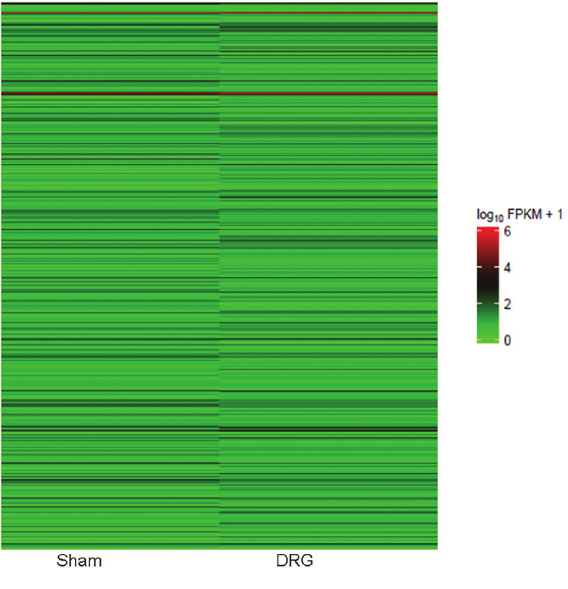
Figure 1. Genetic clustering of differential expression genes (threshold: fold-change 4 2). Red color represents high fold-change, green color represents low fold-change. Names were omitted due to many lines overlapping. DRG: dorsal root